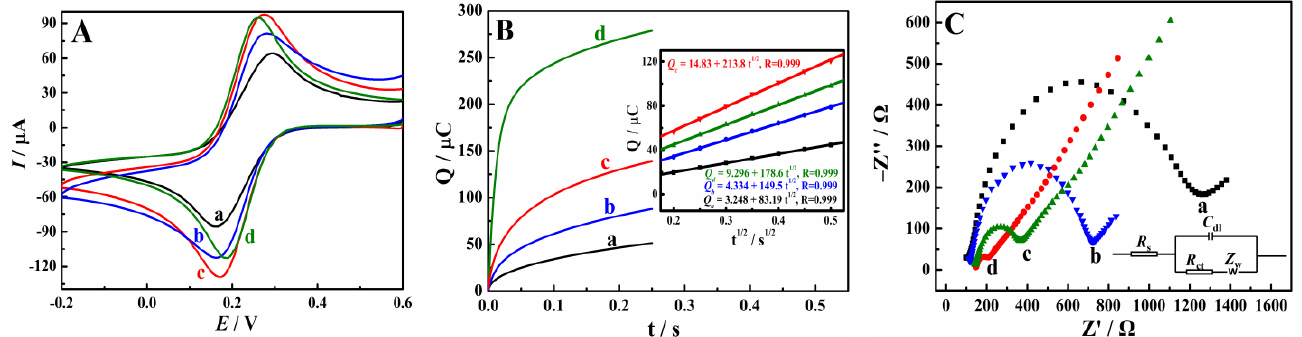
Figure 3. CV behaviors ( A ) and Q -t curves ( B ) of different GCEs in 5.0 mM K 3 [Fe(CN) 6 ] (1.0 M KCl), inset: Q -t 1/2 plots; ( C ) Nyquist impedance plots of different GCEs in 5 mM K 3 /K 4 Fe(CN) 6 (0.1 M KCl). The measurements were carried out at the open circuit potentials. R s , R ct , C dl , and Z w represent the solution resistance, the electron transfer resistance, the double-layer capacitance, and Warburg impedance, respectively. The used electrodes are GCE (a), Cu-TCPP/GCE (b), Cu-TCPP/graphene/GCE (c), and graphene/GCE (d).